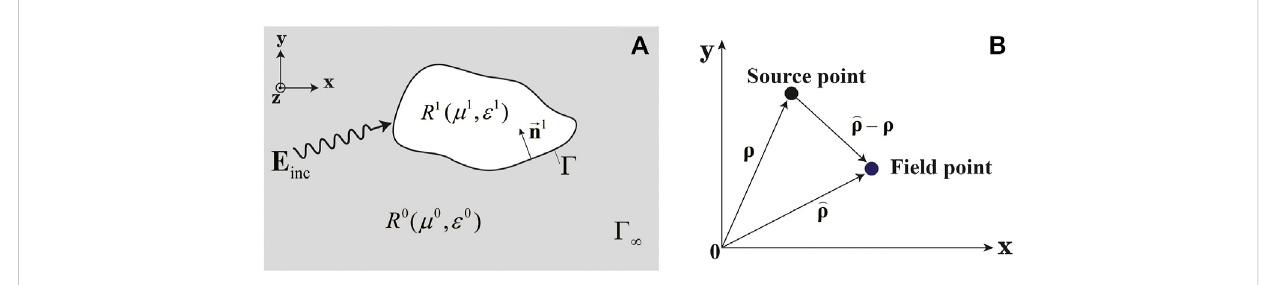
FIGURE 1 Diagramoftheelectromagneticscattering. (A) Tworegions R ι : R 0 isanunboundeddomaininwhichthefreespaceparametersareassigned( μ 0 , ε 0 ); Γ denotes the boundary of R 1 . On each of its interfaces, the normal vector (cid:1) n 1 points into R 1 . (B) Near- fi eld diagram.